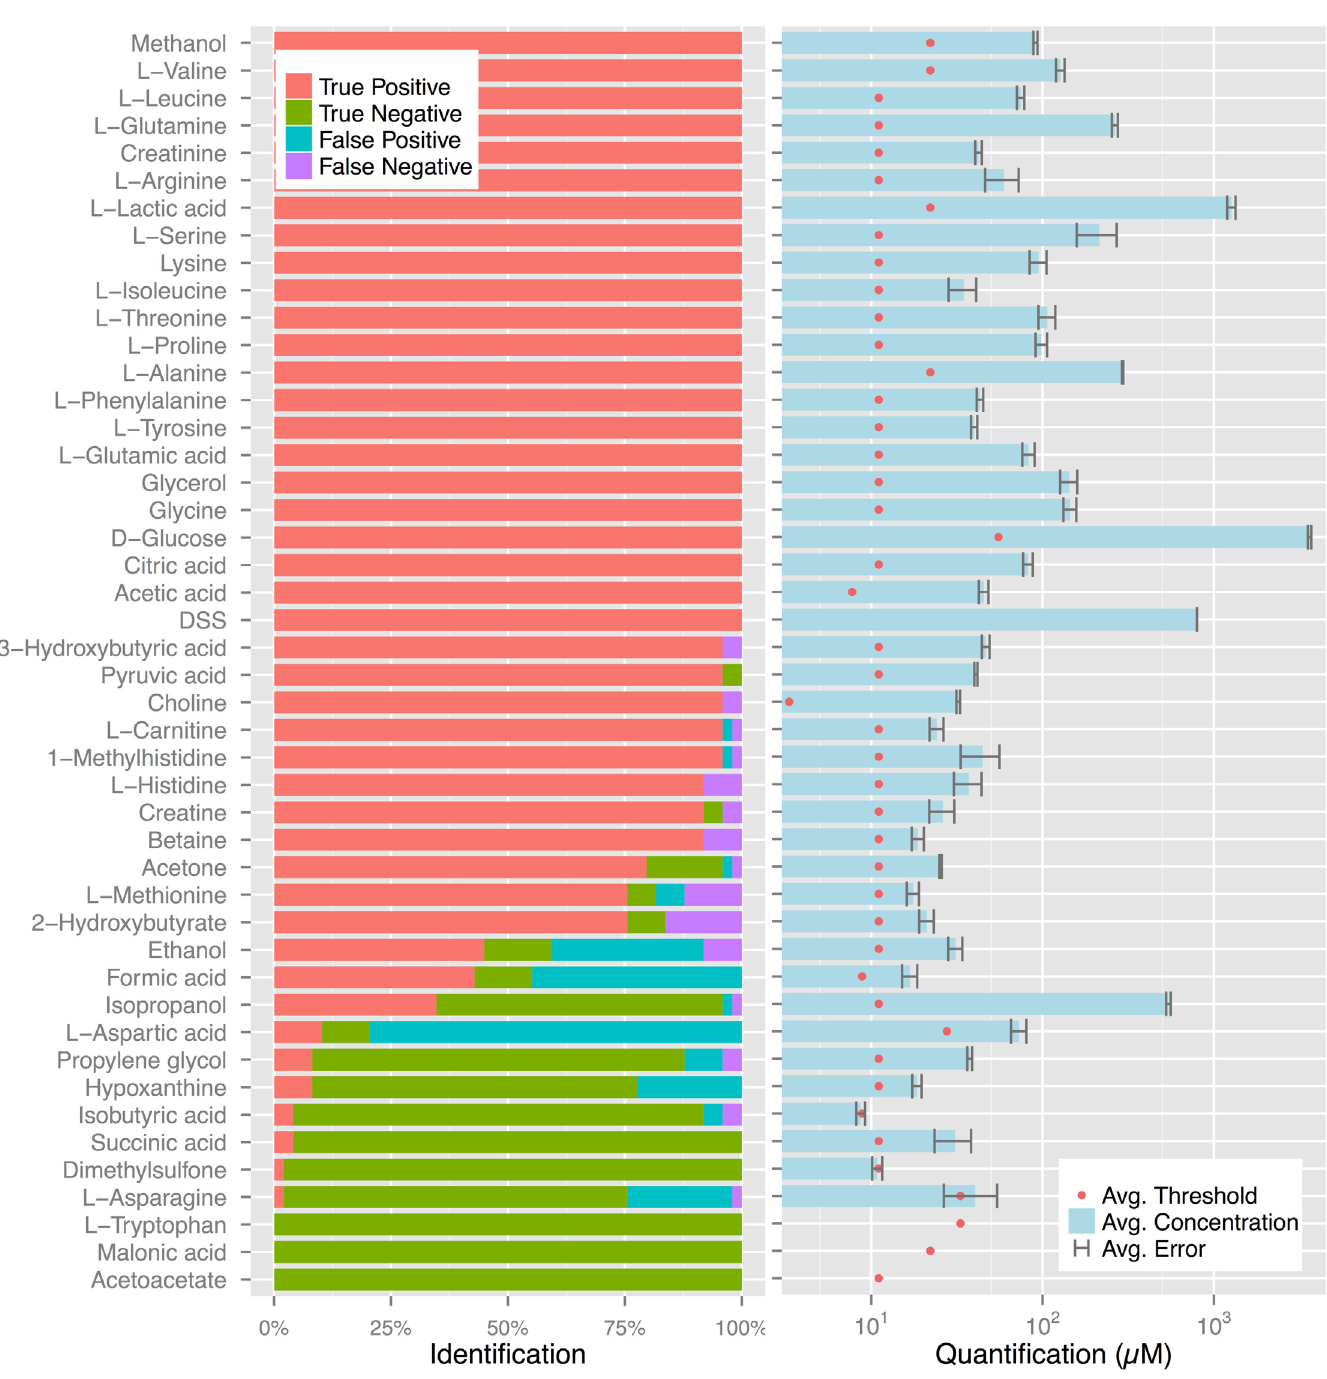
Fig 6. Bayesil ’ s quantification and identification. (left) Bayesil ’ s identification of individual compounds in 50 biological serum samples. (right) The average concentration for correctly identified compounds in the same samples. The error bars show the average difference between Bayesil and expert values for each compound and the red dots show the average detection threshold for the same